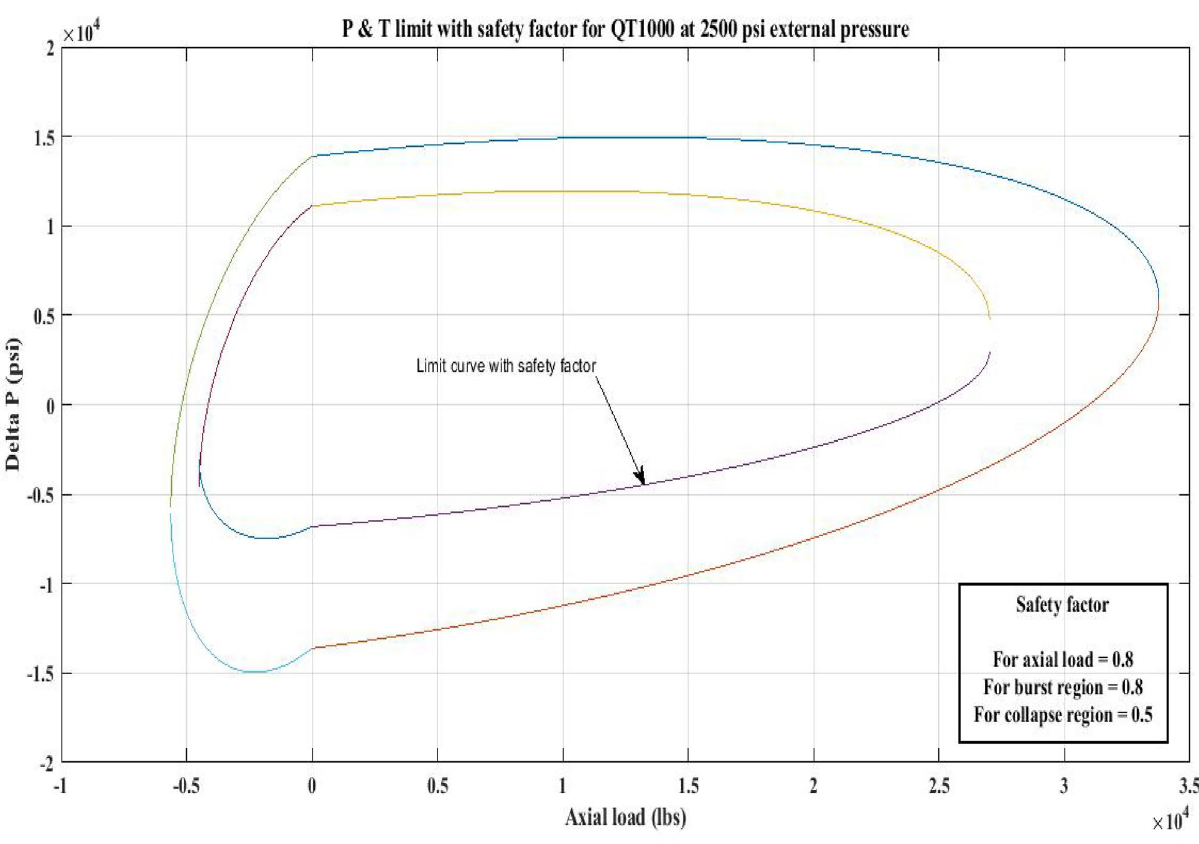
Figure 23. P and T limit with safety factor for QT 1000 at 2500 psi P o